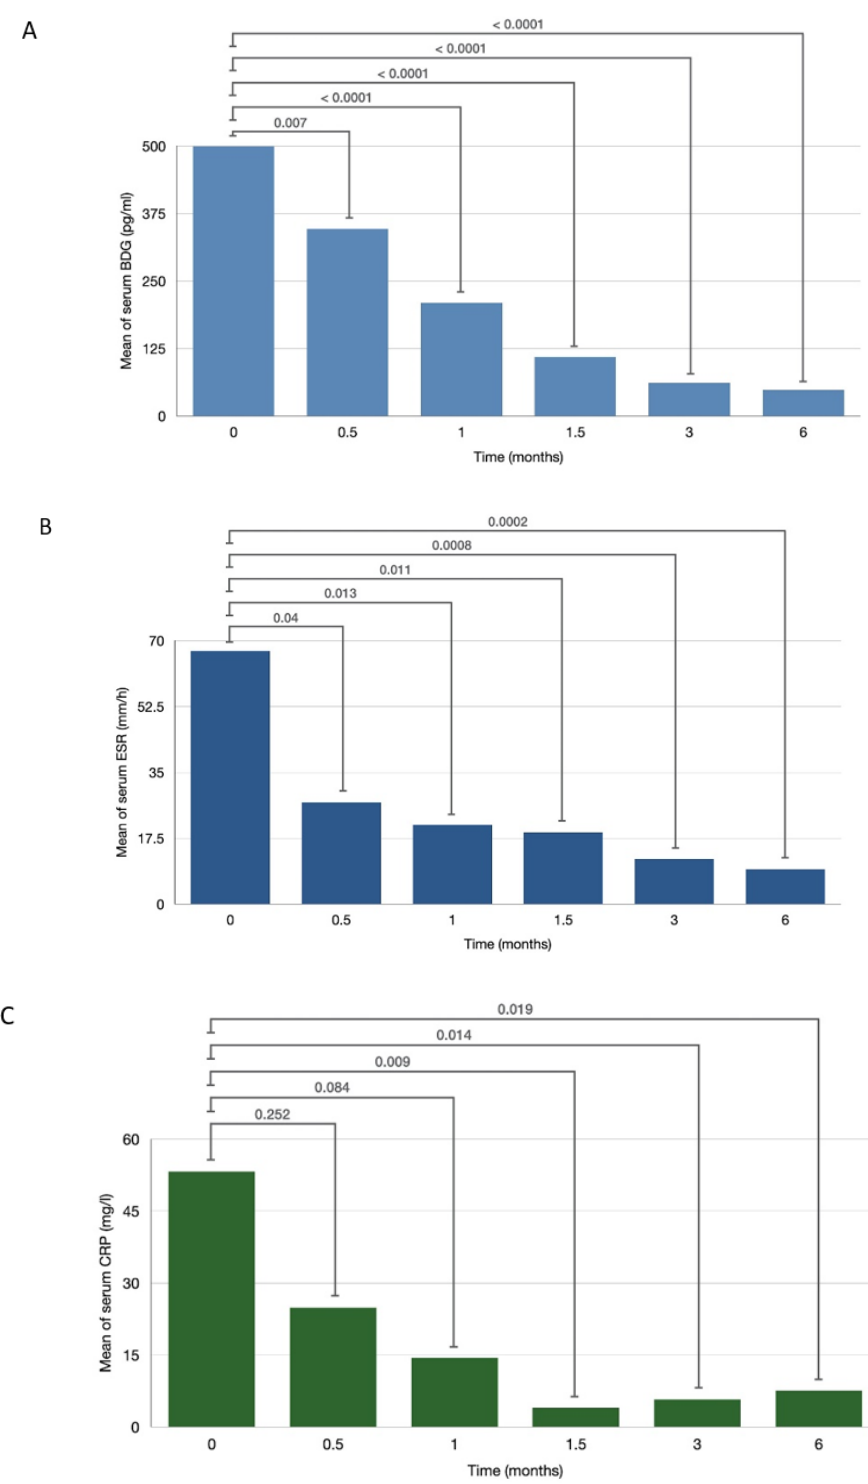
Figure 1. Means of serum β-d-glucan (BDG) ( A ), serum erythrocyte sedimentation rate (ESR) ( B ), and serum C-reactive protein (CRP) ( C ) across different time